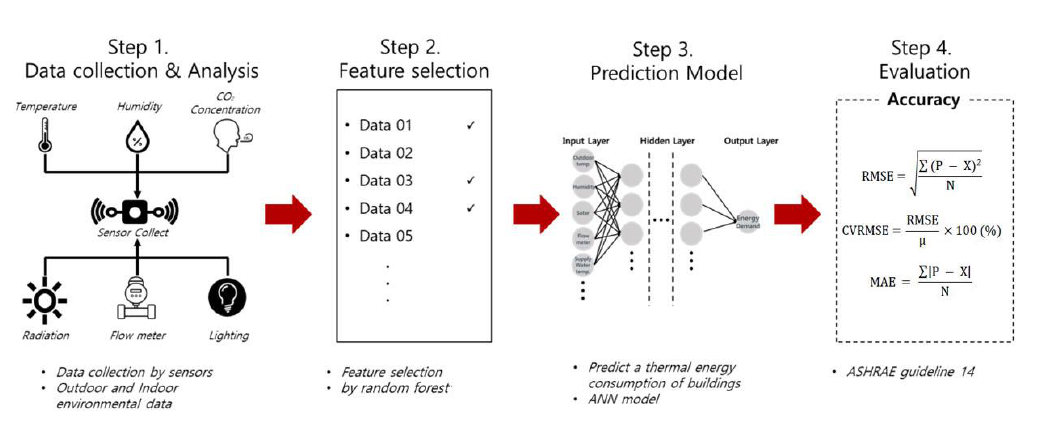
Table 5. Information on each sensor.